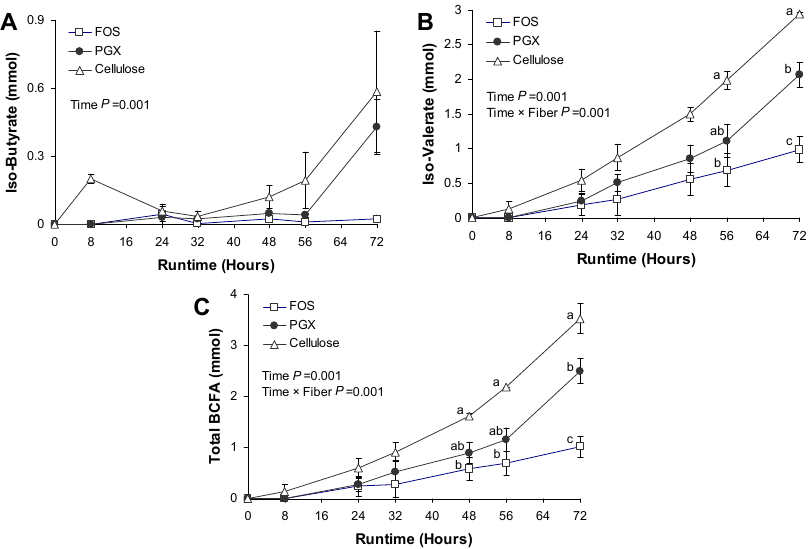
Figure 4. The average cumulative production of ( a ) iso -butyrate, ( b ) iso -valearate and ( c ) total BCFA in TIM-2 during 72 h on the fructooligosaccharide (FOS), PolyGlycopleX (PGX) or cellulose substrate. Values are mean ± SEM ( n = 2 for FOS and cellulose and n = 3 for PGX). Labeled means without a common letter at the same time point differ, p < 0.05. Y -axis scales differ across